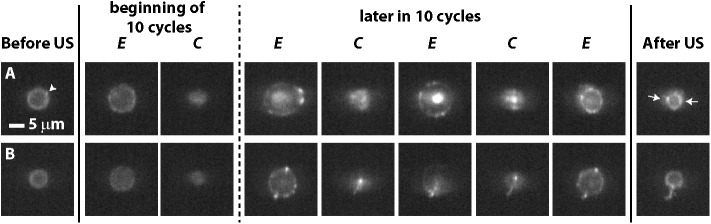
Microbubbles insonified at frequency of 1 MHz and higher P_.Insonification at P_ of 300 kPa and 10 cycles (A) or P_ of 150 kPa and 15 cycles (B). Arrow head in leftmost column indicates hot spot present before insonification; arrows in rightmost column indicate hot spots formed during insonification that persisted when the ultrasound was off; see S7 and S8 Videos for the ultra-high-speed recordings of the shown selected frames. US = ultrasound; E = expansion phase; C = compression phase.